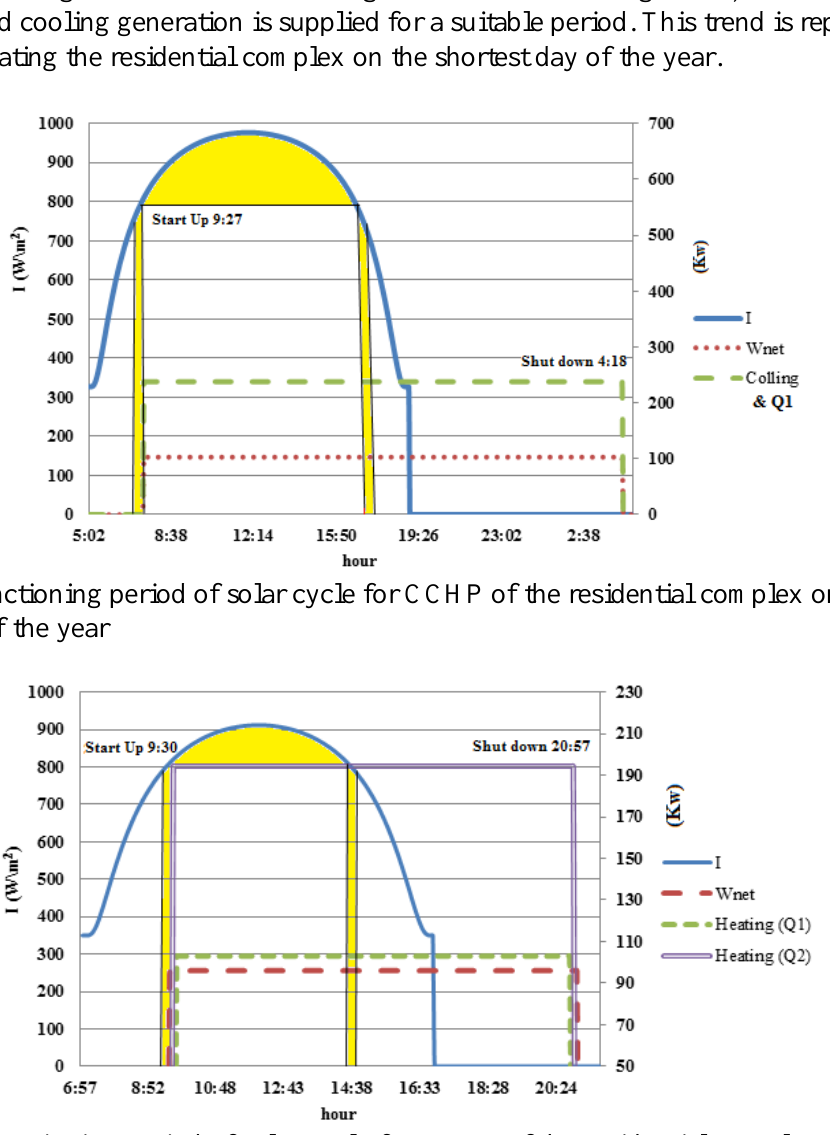
Figure 10. Functioning period of solar cycle for CCHP of the residential complex on the shortest day of the